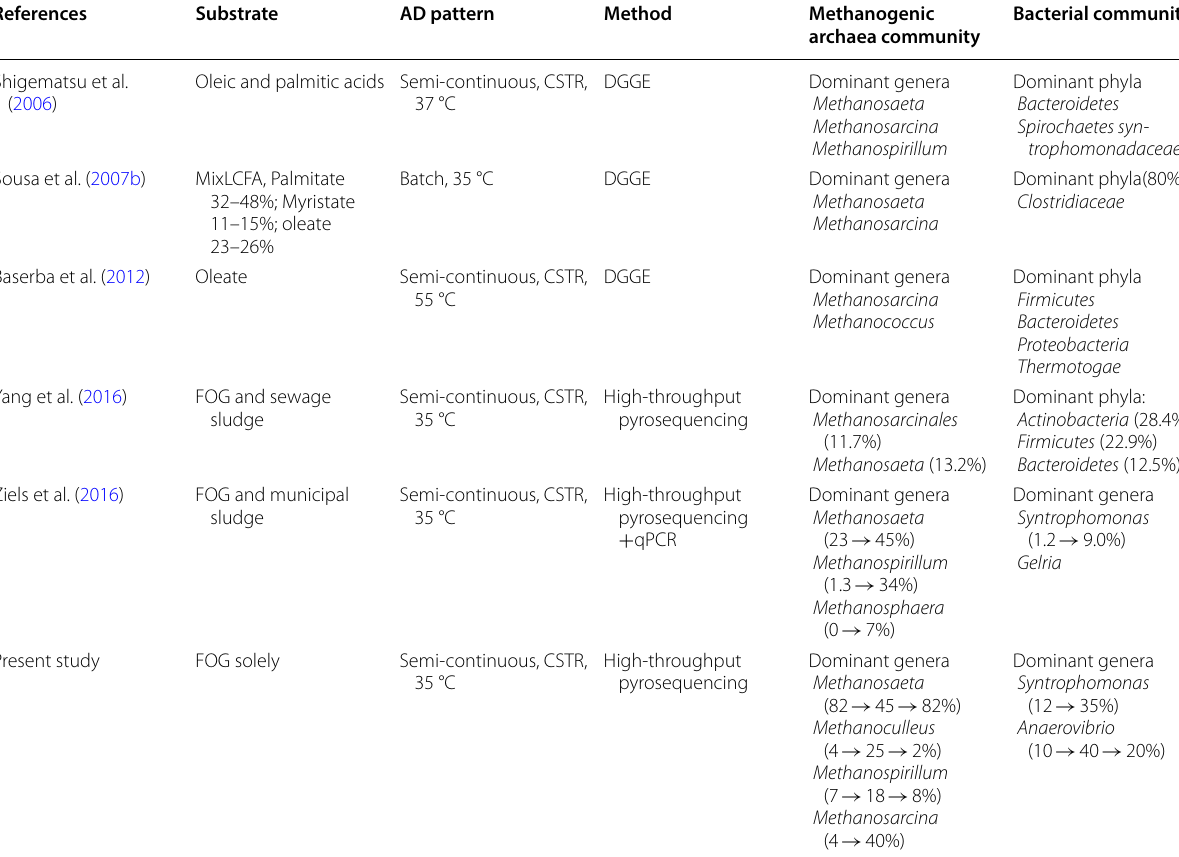
Table 3 Characterization of microbial community of AD with LCFA or